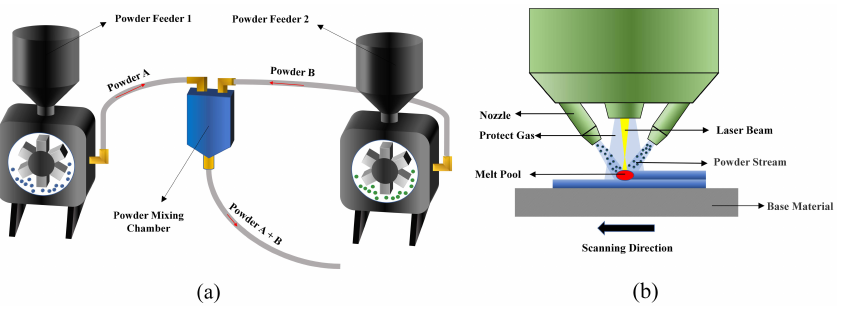
Figure 1. Schematic diagram of the LENS System. ( a ) Working principle of the dual-powder feeder. ( b ) Schematic diagram of the LENS working